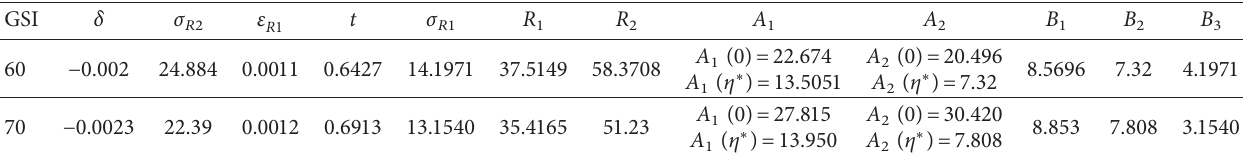
Table 3: Dataset.